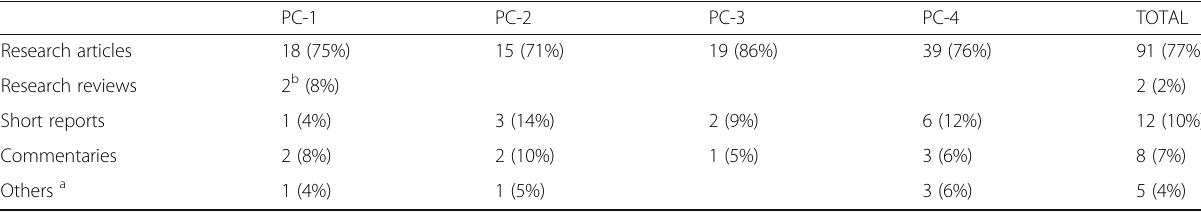
Table 1 Number (percentage) of publications of each type by publication cycle year